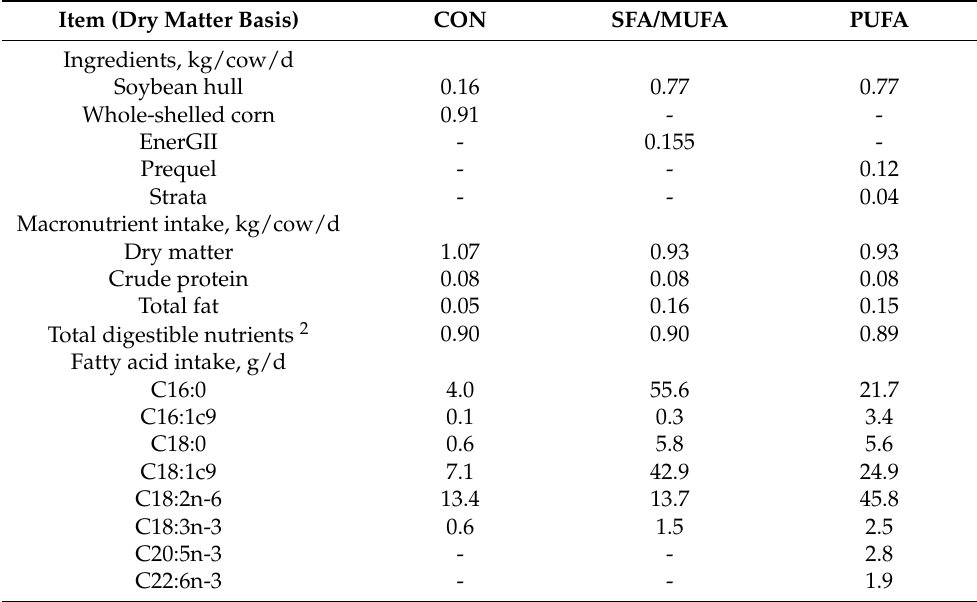
Table 1. Supplement composition and nutrient intake from treatment supplements containing soybean hulls mixed with whole-shelled corn (CON), Ca salts of saturated/monounsaturated fatty acids (SFA/MUFA), or Ca salts of polyunsaturated fatty acids (PUFA) 1 . Item (Dry Matter Basis)